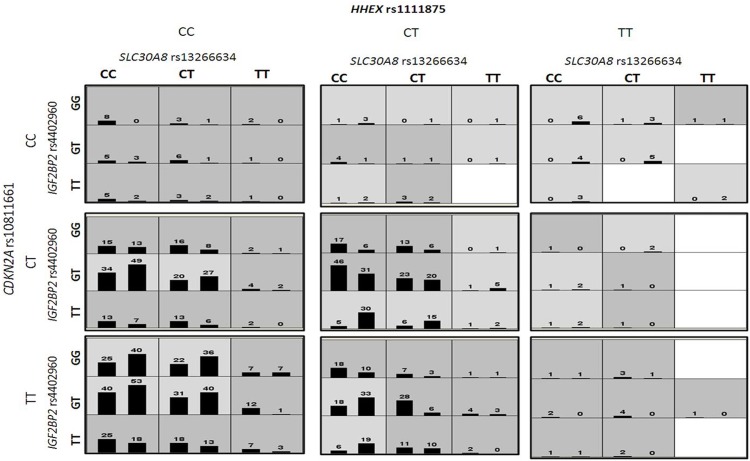
The best four-locus SNP model selected by MDR.Interaction of SLC30A8 (rs13266634), IGF2BP2 (rs4402960), HHEX (rs1111875) and CDKN2A (rs10811661) polymorphisms is shown. Cells shaded in dark represents higher risk groups and lighter shaded cells represents lower risk groups. White cells or no shaded cells represent genotype combination where no data are available. Bars represent hypothetical distributions of cases (left) and controls (right) with each multifactor combination.